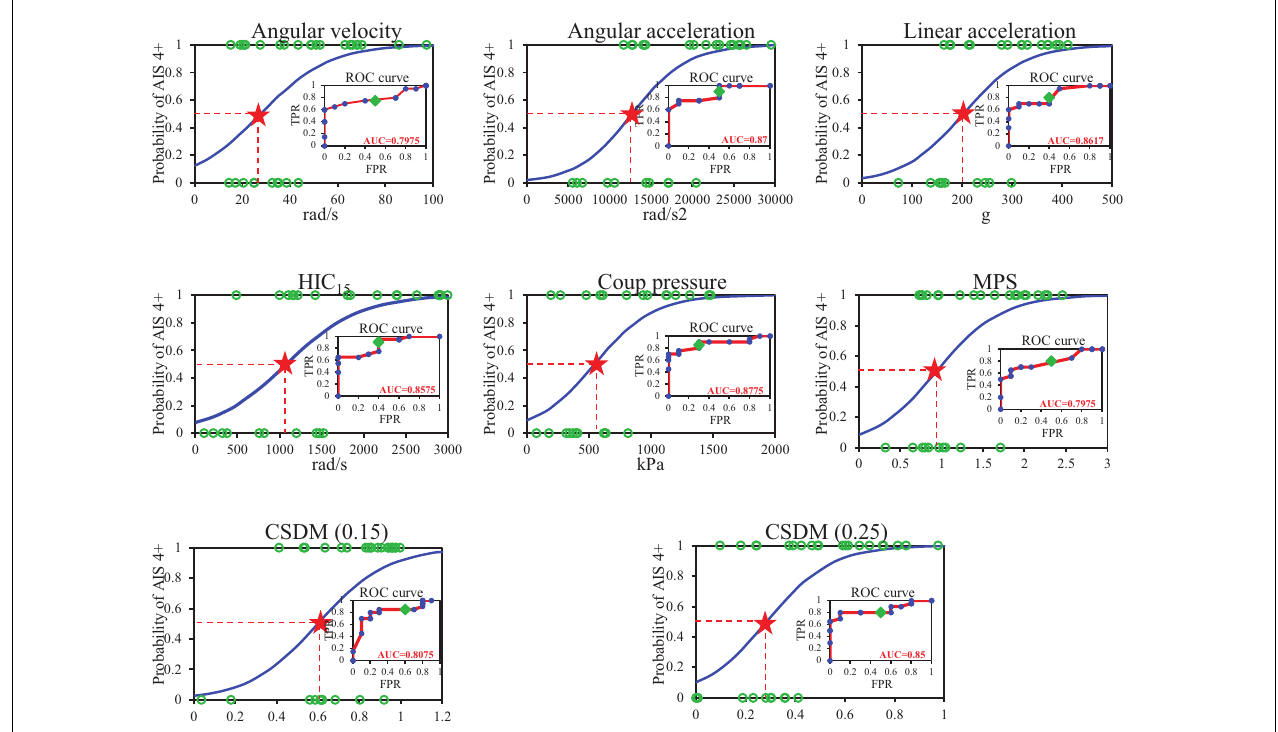
FIGURE 4 | Head AIS 4+ injury risk curves for the head kinematic based